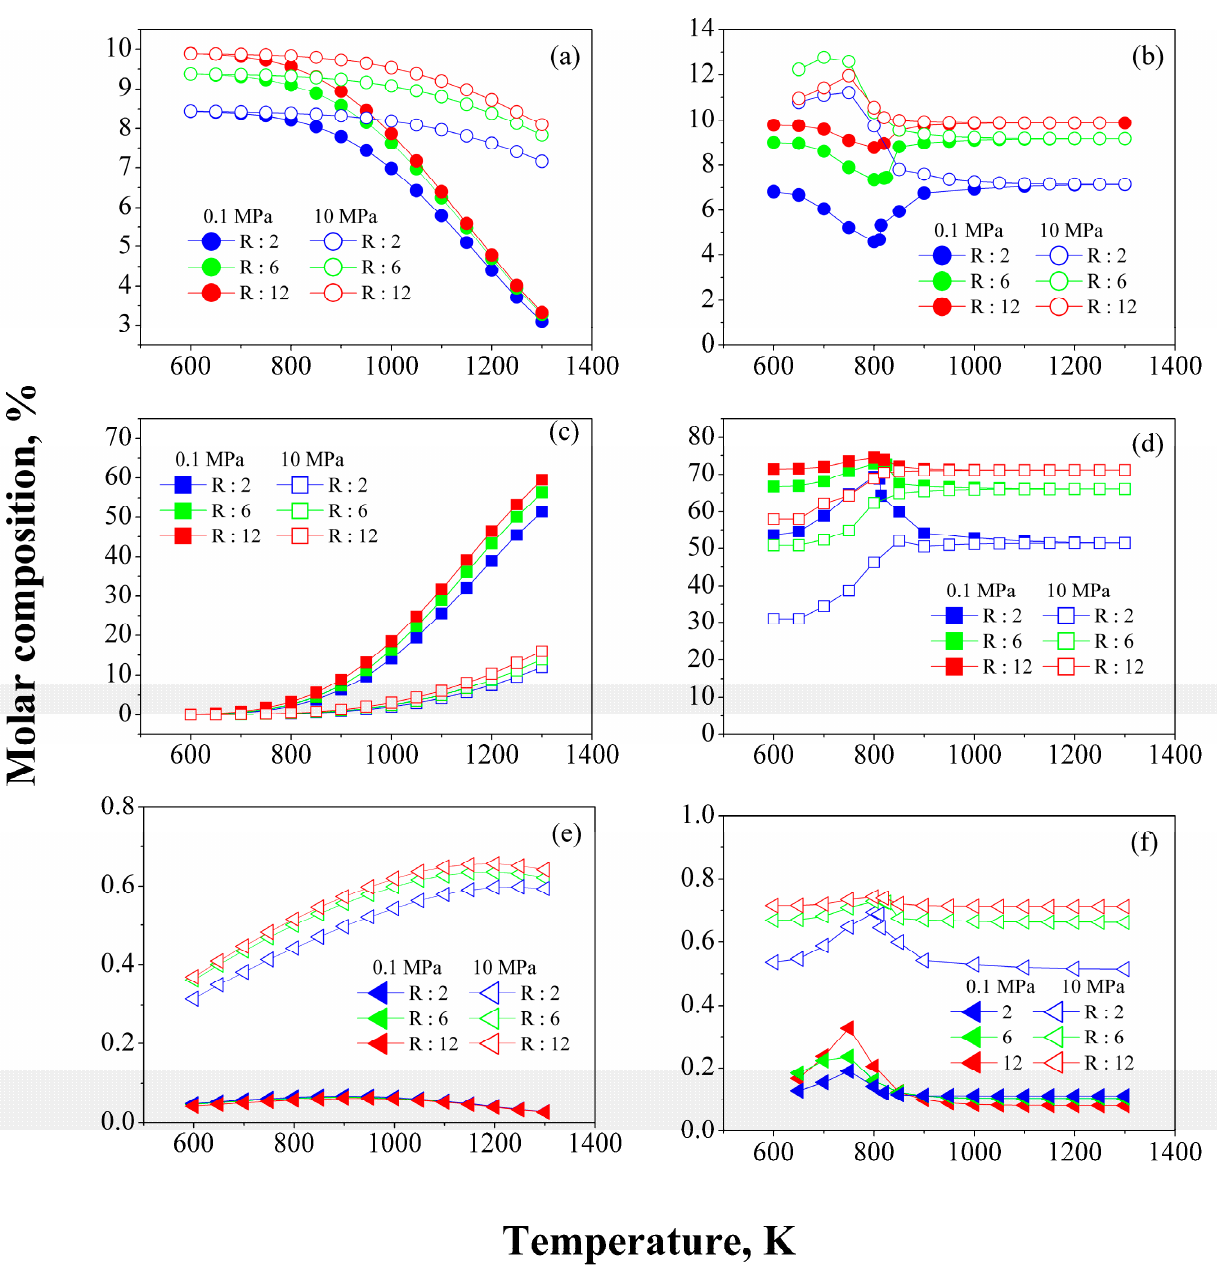
Figure 5. Effect of H 2 /HC molar ratio on gas products: ( a , c , e ) Equilibrium. ( b , d , f ) Catalytic.